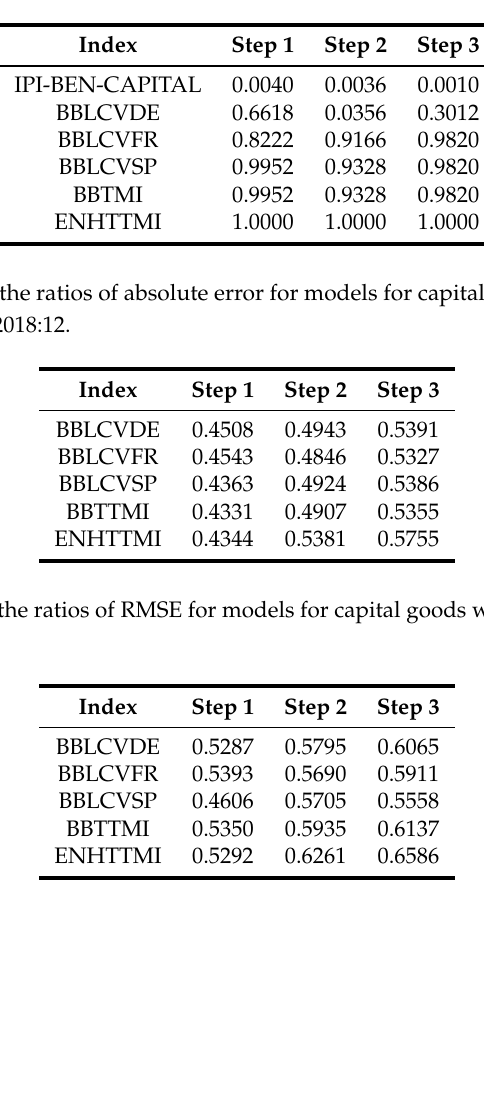
Table 10. Model confidence set hierarchy loss function is the absolute error at the end of the sample for